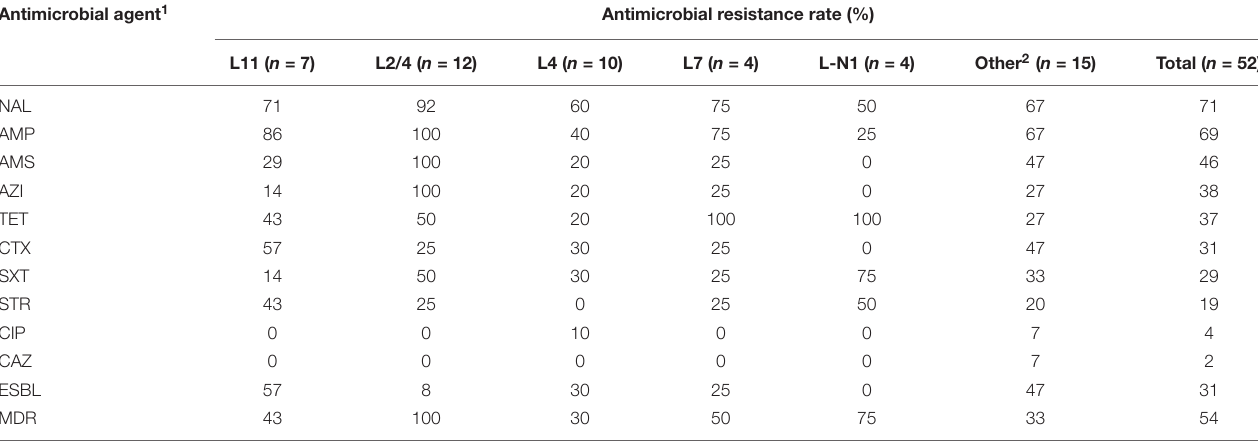
TABLE 2 | Antimicrobial resistance of 52 representative Shenzhen ETEC isolates. Antimicrobial agent